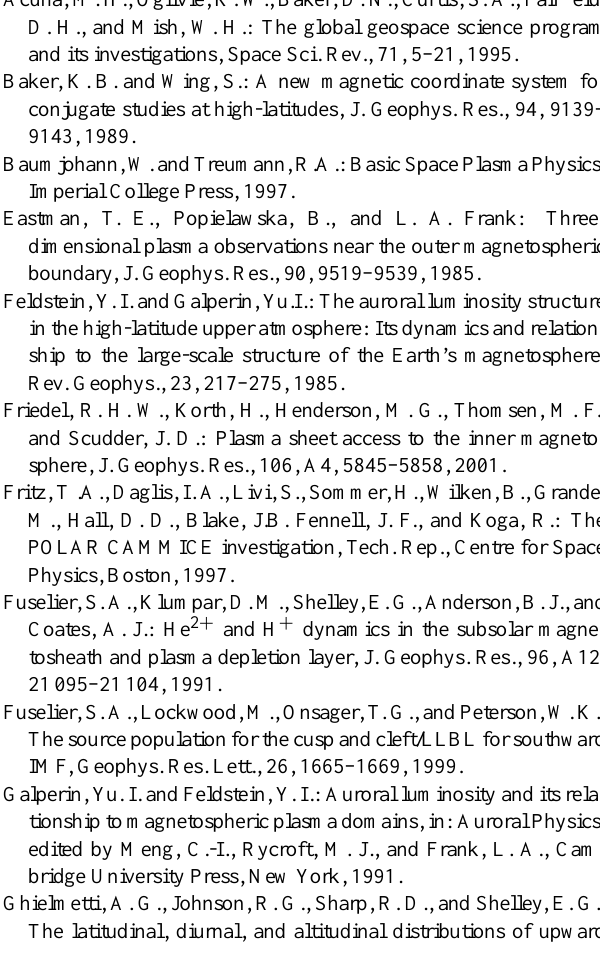
Figure 1 was reproduced and modified by permission of the Amer- ican Geophysical